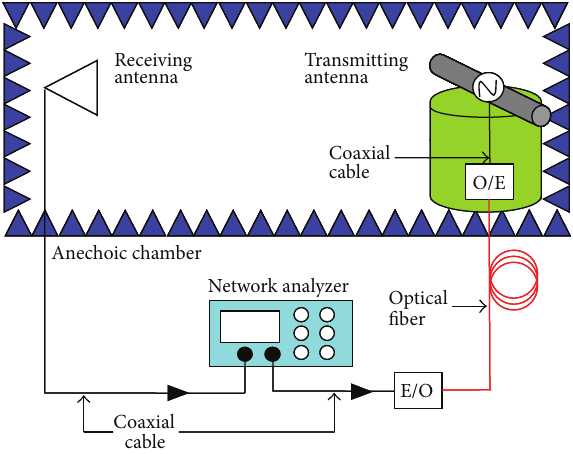
Figure 1: Measurement setup of optical feeding.